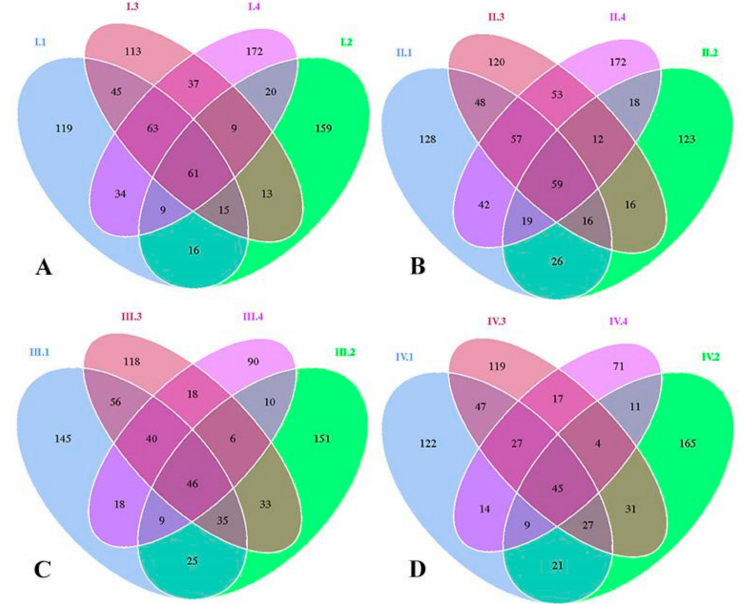
Figure 1. ( A–D ). Venn diagrams of operational taxonomic units (OTUs) for the four experimental periods I (1–18 d), II (19–36 d), III (37–54 d), and IV (55–72 d). Each period also shows the distribution of four groups 1, 2, 3, and 4 of Karakul sheep treated with four dietary non-fibrous carbohydrate / neutral detergent fiber (NFC / NDF) ratio of 0.54, 0.96, 1.37, and